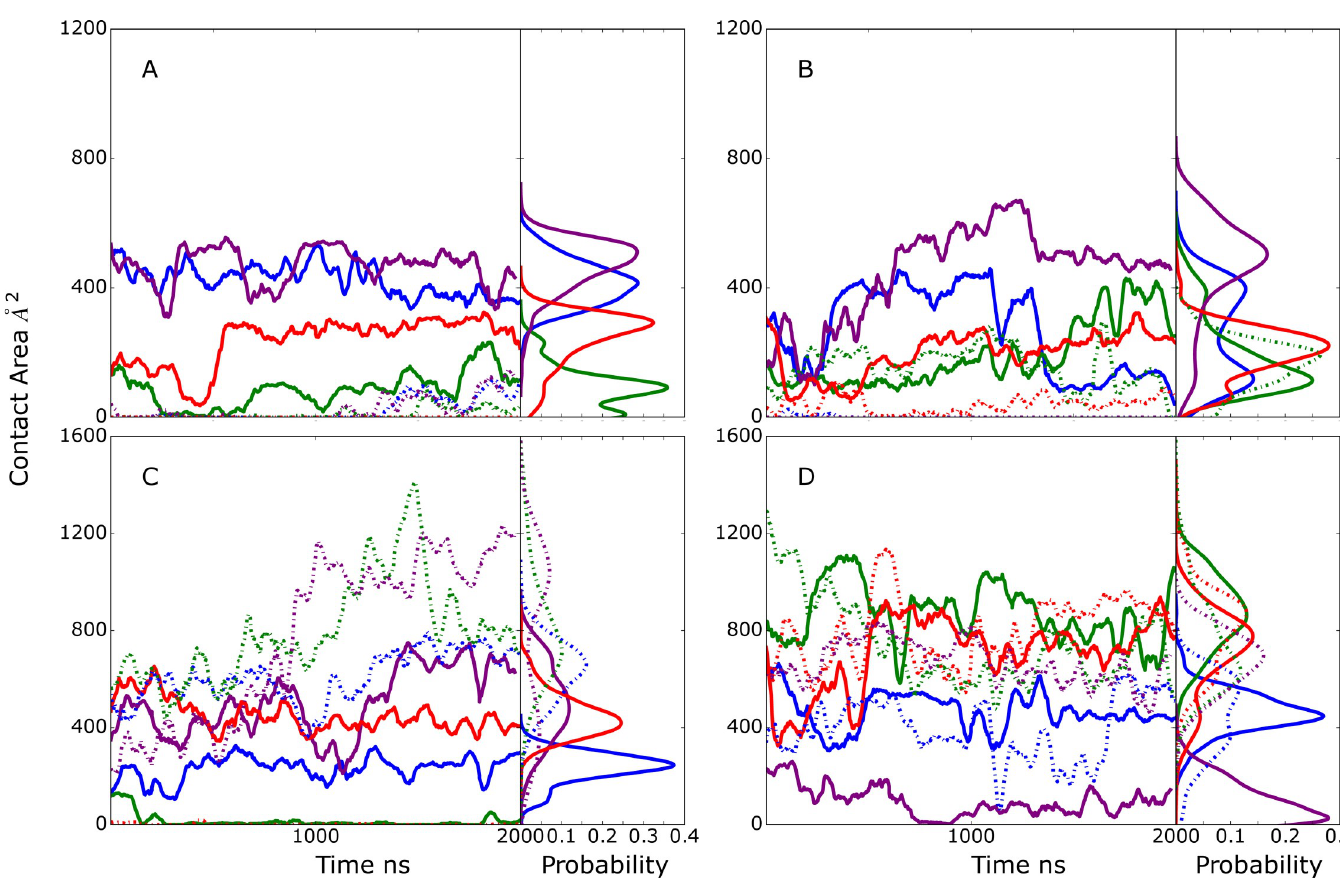
Fig 7. Model D time series and probability distributions of the contact area, Å 2 , between A) the first glycan (glycan interacting with CBM) of the Fc and the CBM, B) the second glycan (interacting with GH) of the Fc and the GH, C) the Fc protein chain hosting the first glycan and the CBM, and D) the Fc protein chain hosting the second glycan and the GH during the MD simulations. Results shown for individual MD simulations 1) blue, 2) green, 3) purple and 4) red. Data is presented as a 50 ns moving average. Light-dash lines represent the contact area between second glycan or Fc CH2/CH3 domain hosting the second glycan and CBM (panel A and C) and between first glycan or Fc hosting first glycan and GH (panel B and D), while solid lines represent the contact area between first glycan or Fc CH2/CH3 domain hosting first glycan and CBM (panel A and C) and between second glycan or Fc hosting second glycan and GH (panel B and